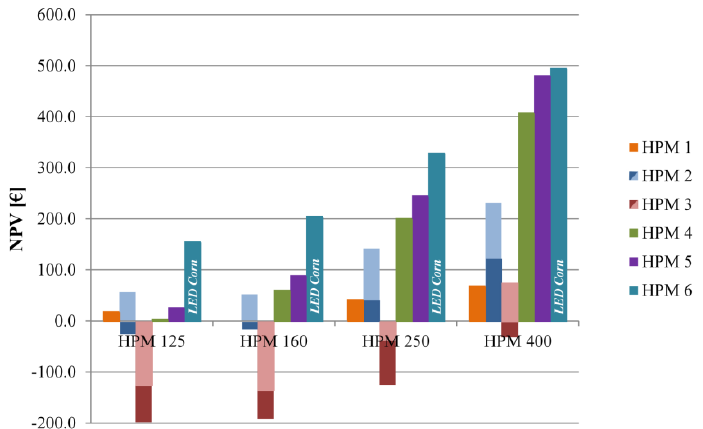
Figure 8. NPV of proposed energy efficiency measures for HPM lamps.